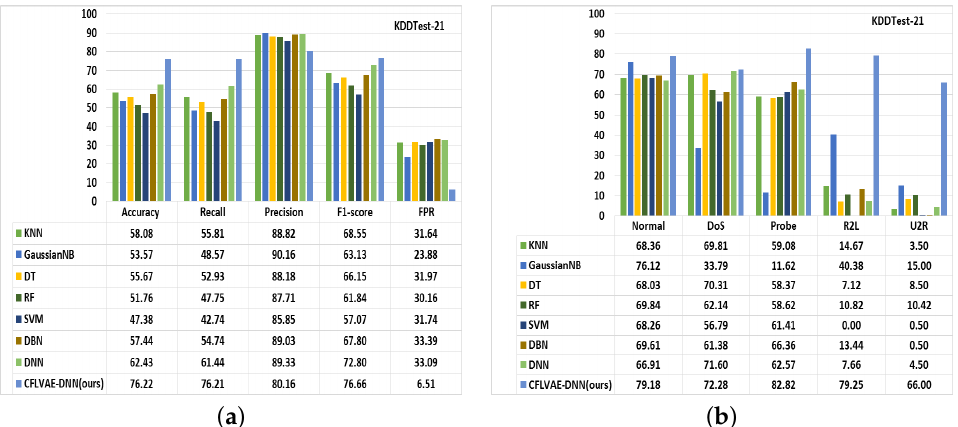
Figure 13. Comparison of ( a ) Overall performance and ( b ) Class-wise detection rates of learning- based classifiers on the NSL-KDD (KDDTest-21) dataset (in